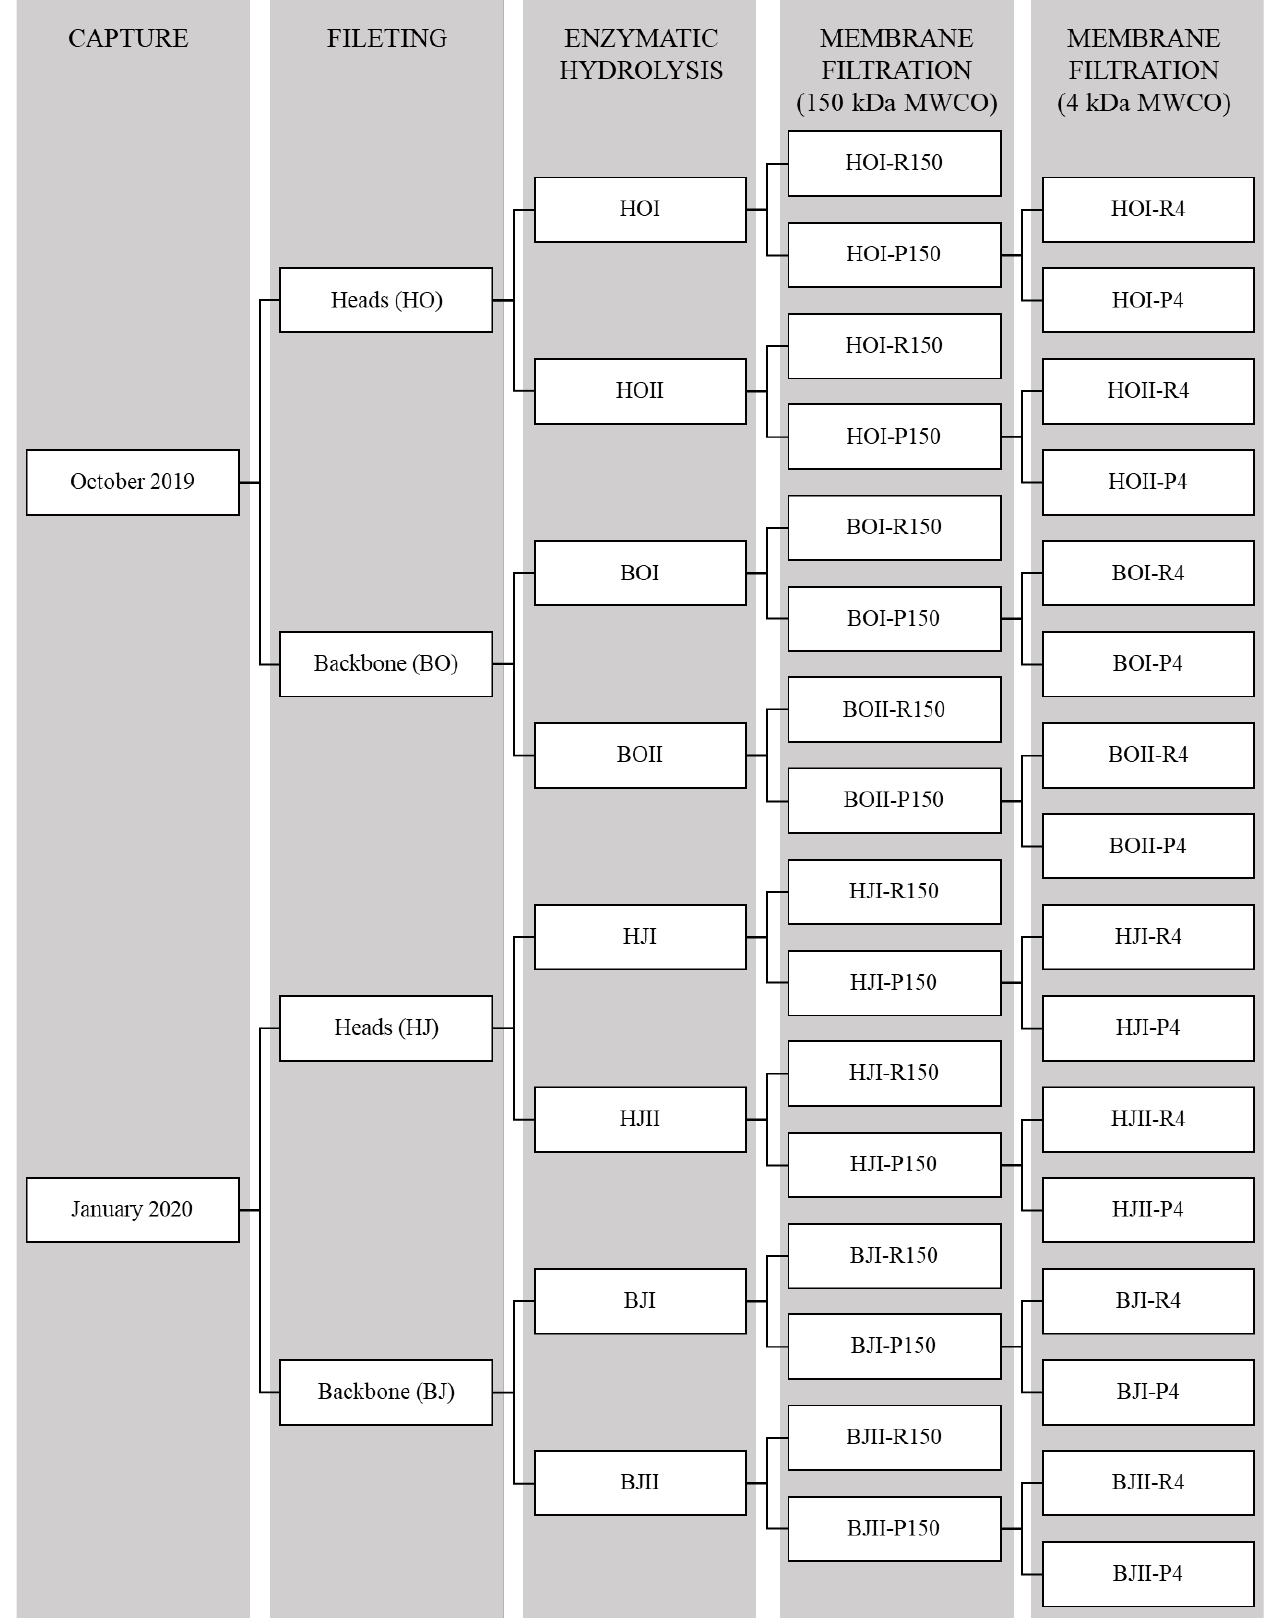
Figure 8. Overview of the processing steps and products generated from capture, filleting, and enzymatic hydrolysis of saithe rest raw material [3] and two membrane filtrations of saithe protein hydrolysates.